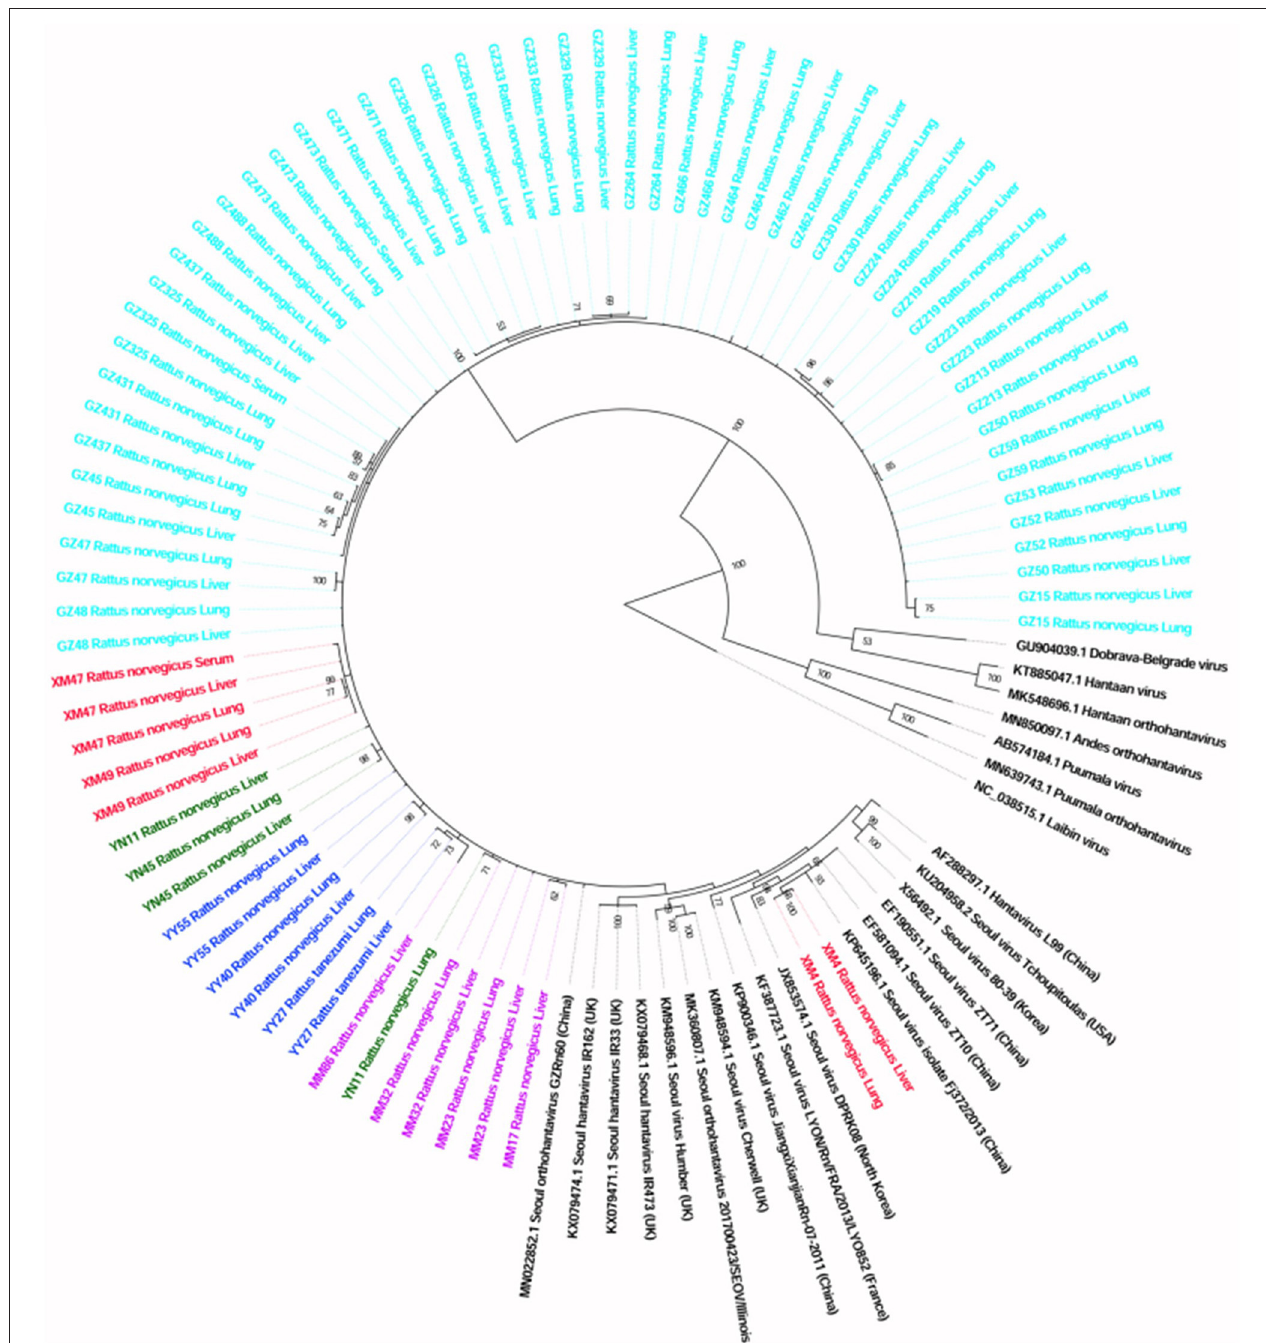
FIGURE 2 | Phylogenetic tree constructed using PCR screening nucleotide sequences of Seoul virus obtained from rats. Twenty-two representative orthohantavirus sequences were included for comparison, and one Laibin virus sequence was set as the outgroup. The percentages of the posterior probability (PP) values are